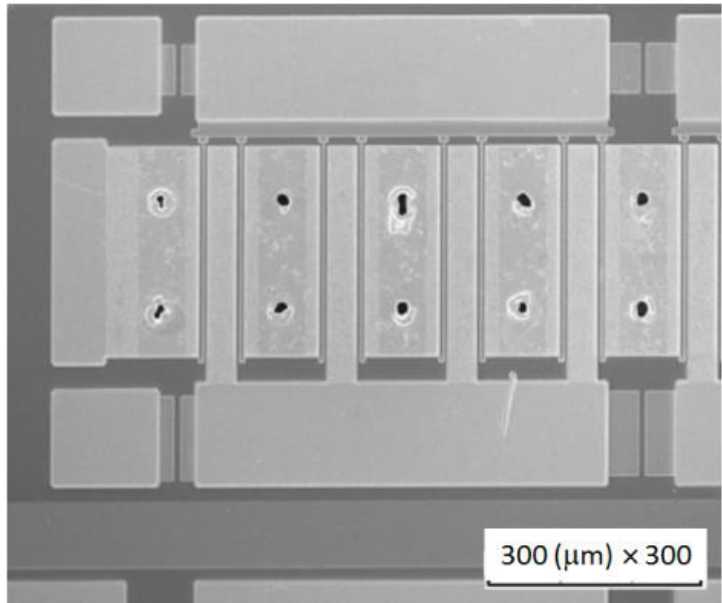
Figure 5. Inner slot via hole shape on source pad (© 2019 IEEE. Reprinted, with permission, from W. S. Lee, et al., “A GaN/Diamond HEMTs with 23 W/mm for Next Generation High Power RF 1395 – 1398